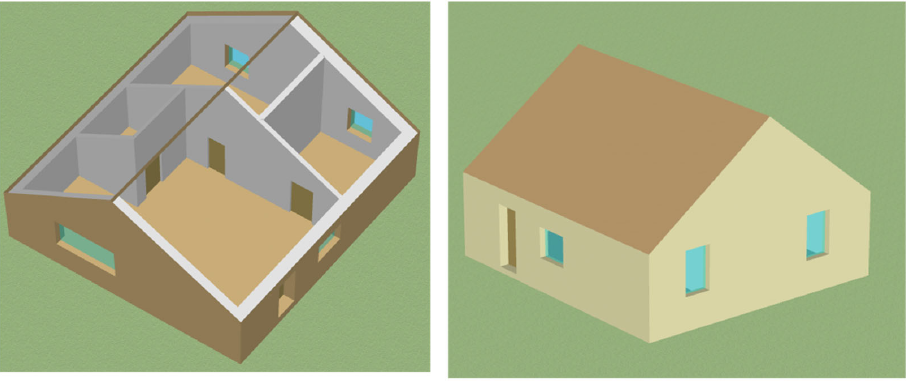
Figure 4. Simulated structure. Table 3. The composition of the walls, roof, and